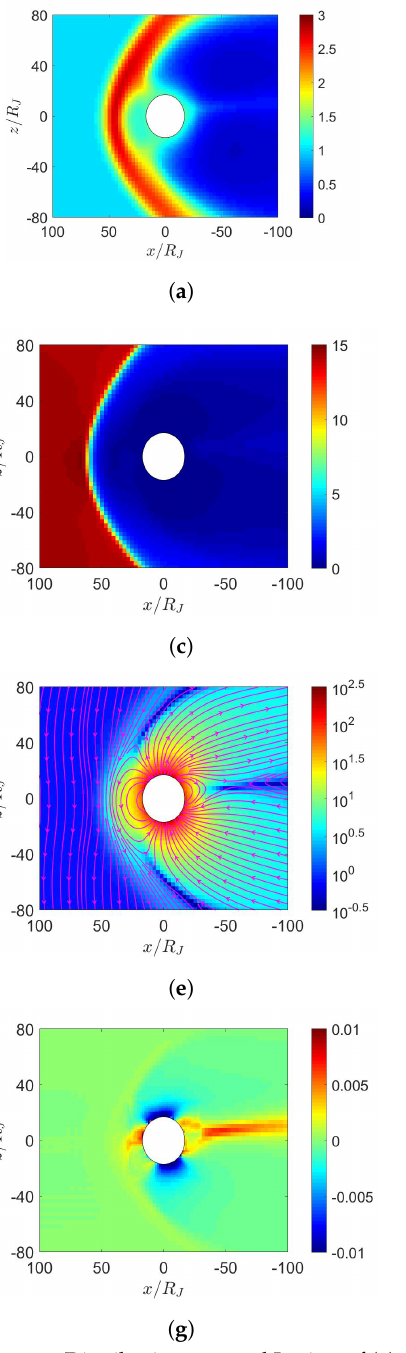
Figure 12. Distributions around Jupiter of ( a ) n (cm − 3 ), ( b ) ¯ u xz (km/s), ( c ) magnetosonic Mach number, ( d ) P (nPa), ( e ) ¯ B xz (nT), ( f ) J y (nA/m 2 ), ( g ) J r (nA/m 2 ); maximum dipole tilt points towards sun at t = 0, under southward IMF, t = 21.19